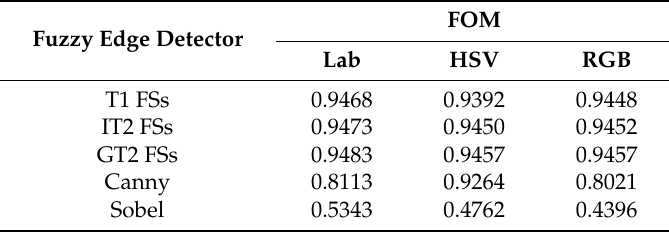
Table 6. Results achieved by T1FSs, IT2FSs, and GT2FSs edge detectors applied on Lab, HSV, and RGB format color images.